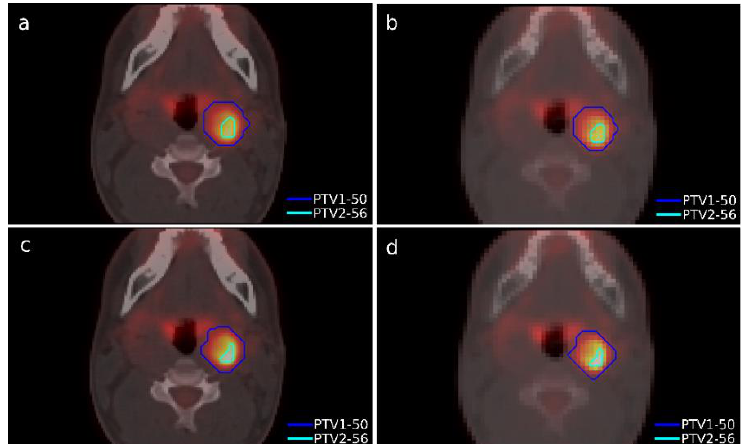
Figure 2. Segmented structures as targets in Case 1 using accreditations from EARL1 (top) and EARL2 (bottom). Contours in the isocenter axial slice of PTV1 and PTV2 in the PET/CT grid ( a , c ) and in the dose calculation grid ( b , d ). The color scale is the same for all figures.